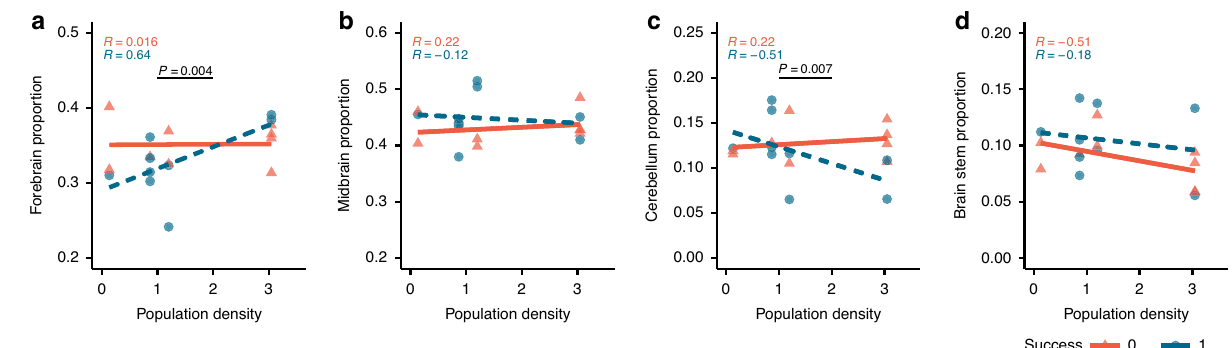
Fig. 2 Relationship between performance, brain part sizes, and population density. a – d Scatterplots and linear regressions of proportions of each brain part size from the total brain size. p- values indicate signi fi cant ( p < 0.05) interaction between brain part size and cleaner population density estimated from Generalised Linear Models. R coef fi cient refers to the Pearson correlation coef fi cient. Red triangles refer to failure while blue circles refer to success in the biological market task. Sample size in a – d is n = 18 biologically independent fi sh.